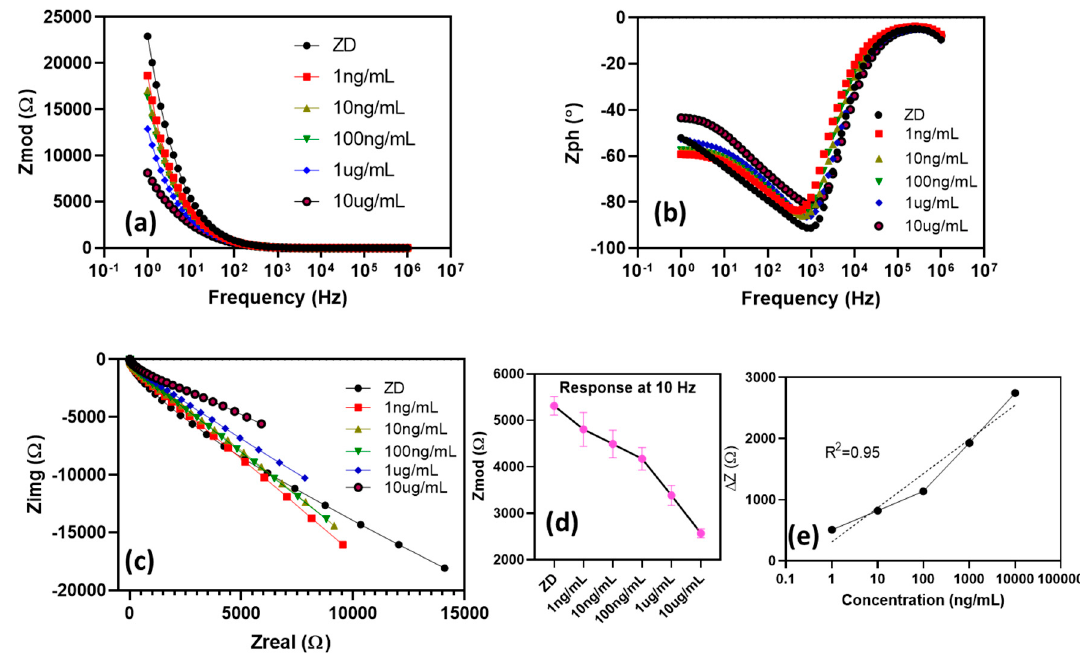
Figure 4. ( a ) Bode magnitude plot representing impedance measurement at every C-reactive protein (CRP) concentration spiked in synthetic sweat (pH 6). ( b ) Bode phase plot for impedance measured corresponding to CRP concentration in synthetic sweat (pH 6). ( c ) Nyquist plot representing change in impedance of CRP in synthetic sweat (pH 6). ( d ) Impedance response at 10 Hz measured at every CRP concentration in synthetic sweat (pH 6). ( e ) Semi-log fit, i.e., log of concentration on x -axis and change in impedance from baseline on y -axis, for n = 3 replicates.